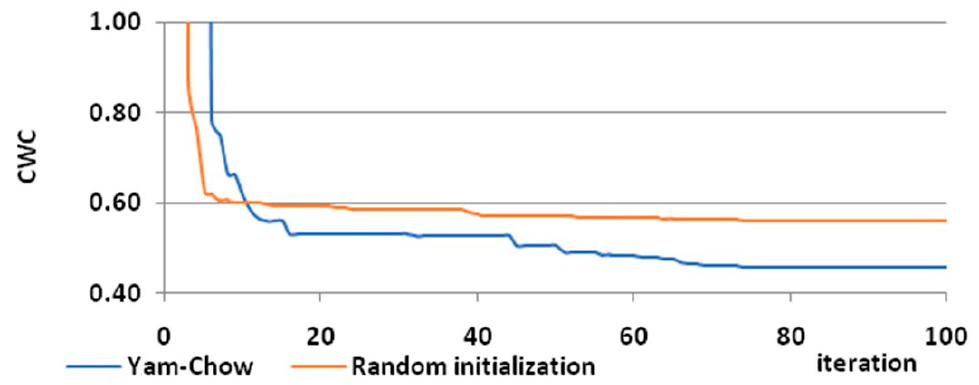
Figure 8. Convergence speed for the proposed model with and without the Yam-Chow initializa-